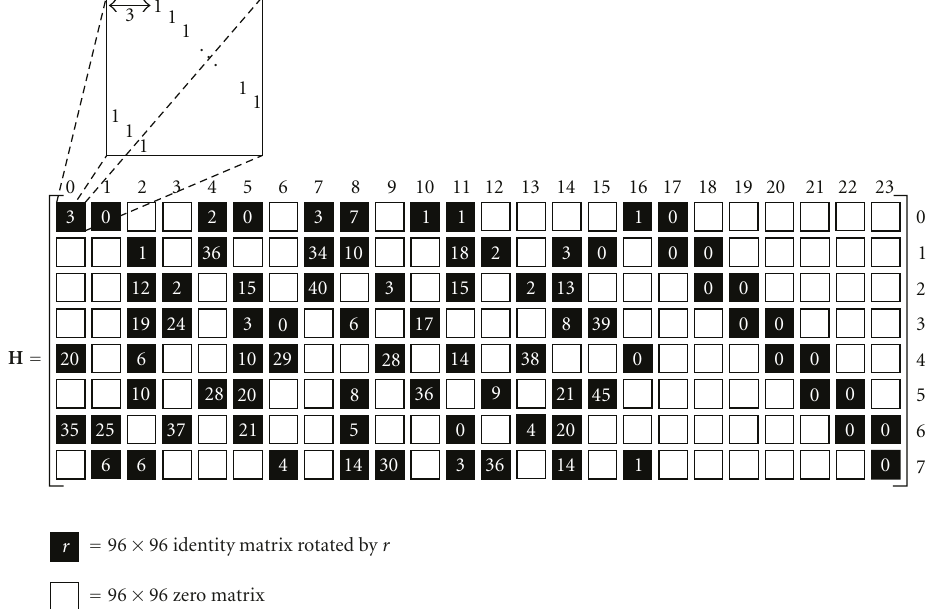
Figure 5: Prototype matrix of WiMAX 2/3a LDPC code with length 2304 ( Z = 96). Di ff erent block sizes are obtained with Z ranging from 24 to 96 in steps of 4 and rotations derived from the code with length 2304 after simple modulo or scaling operations (refer to [6] for further details).